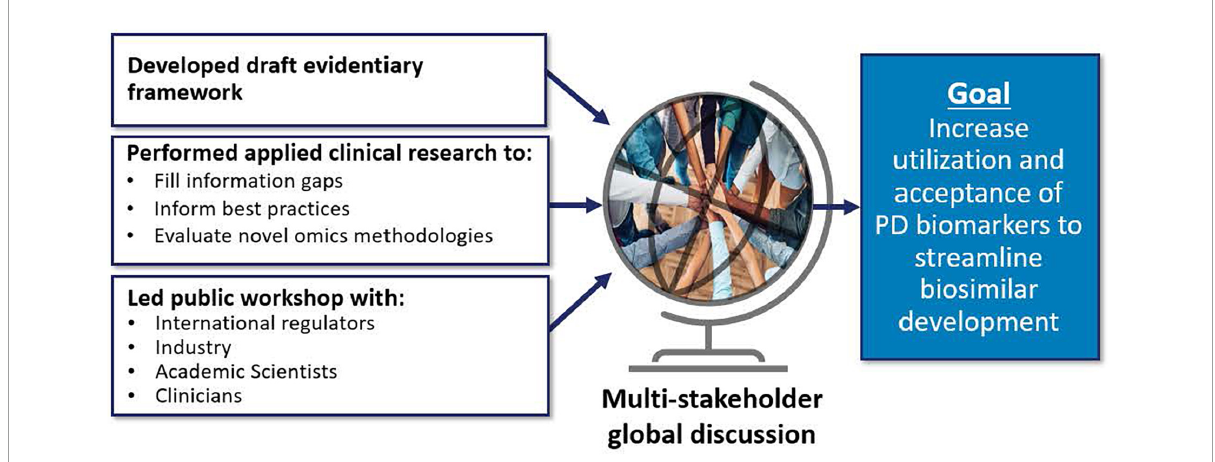
FIGURE7 Many of division of applied regulatory science (DARS’) current initiatives will inform the agency’s thinking on the use of pharmacodynamic (PD) biomarkers to demonstrate biosimilarity that may streamline or negate the need for comparative clinical studies (56, 57). This includes conducting applied clinical research (58–60) to fill information gaps, inform best practices, and evaluate novel omics methodologies (61). DARS also developed an evidentiary framework, the draft version of which was presented at a DARS-led public workshop